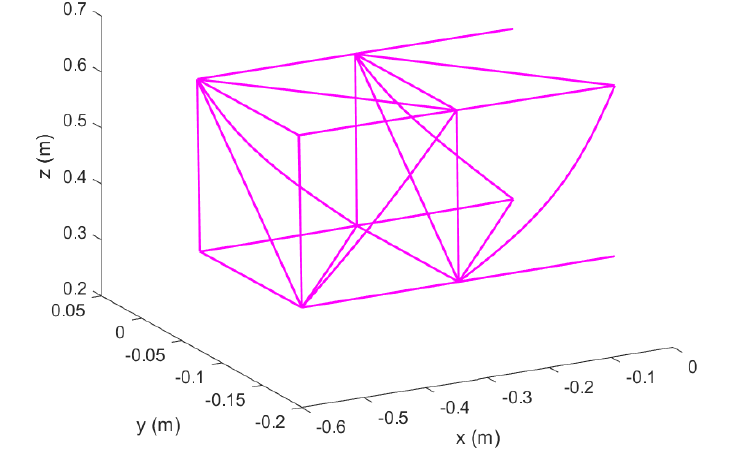
Figure 20. Mode 3 of Euler–Bernoulli Beams in Topology 1 with hinged ends; original configuration.